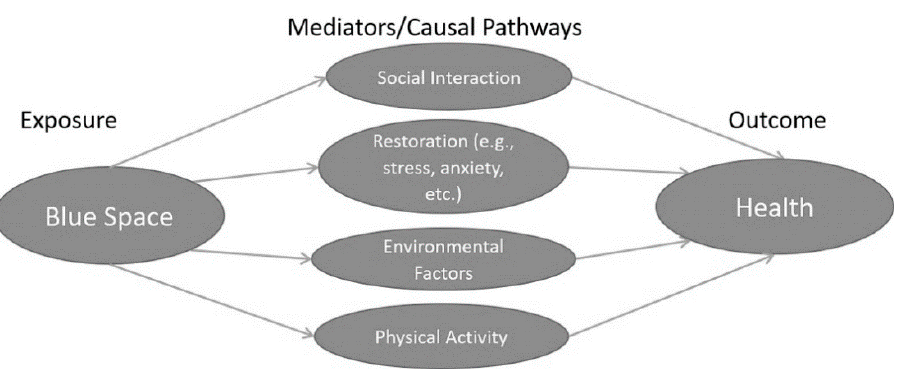
Figure 1. Blue Space—Hypothesised Health Mediators/Causal